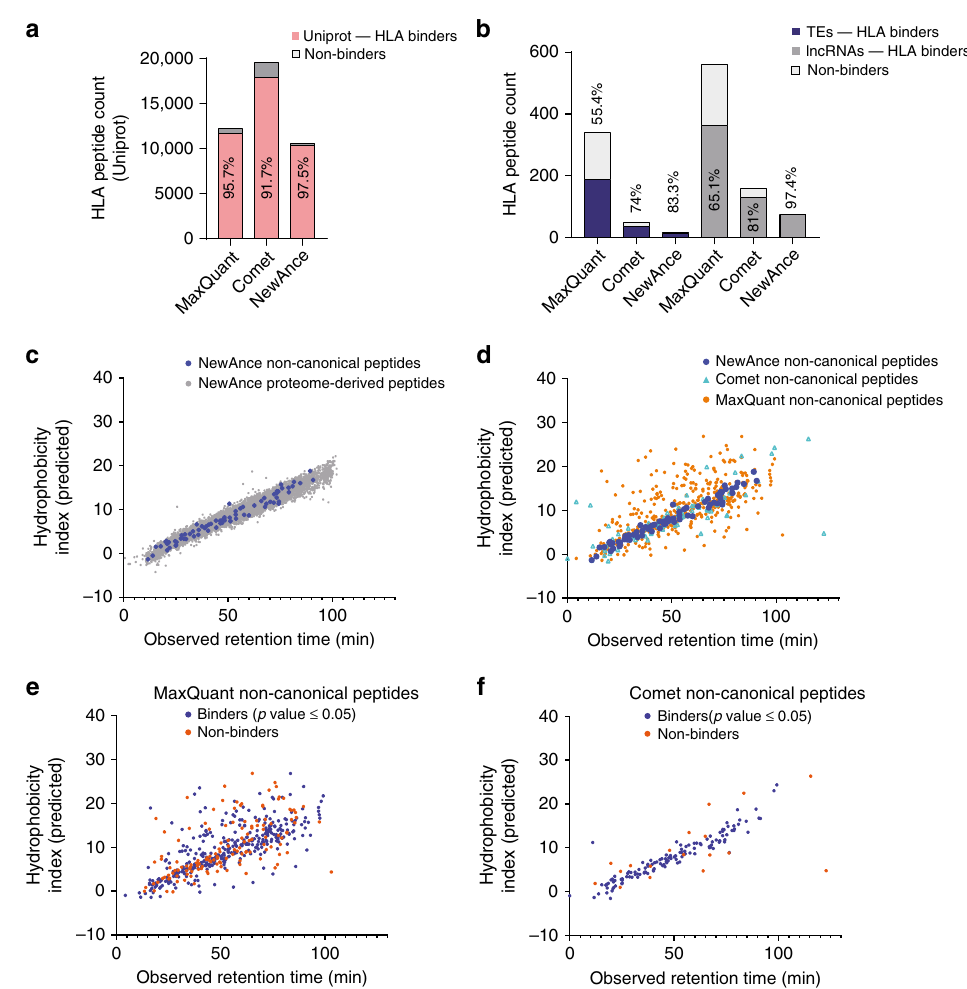
Fig. 2 Two complementary methods to assess the accuracy of NewAnce. a The percentages of predicted proteome-derived HLA-I binders in 0D5P were assessed with each MS search tool (MaxQuant and Comet at FDR 3%) and NewAnce. b Similar to a , the comparisons were performed for the different non-canonical antigen classes. c Hydrophobicity index calculations by SSRCalc for peptides identi fi ed in melanoma 0D5P. The observed mean retention time is plotted against the hydrophobicity indices for NewAnce-identi fi ed proteome-derived versus lncRNA-derived non-canonical peptides. d All peptides identi fi ed with each tool (MaxQuant, Comet, NewAnce) were analyzed based on their hydrophobicity indices. e Hydrophobicity index calculation for MaxQuant- or f Comet-identi fi ed 8- to 14-mer peptides, based on predicted HLA binding. Source data are provided as a Source Data fi